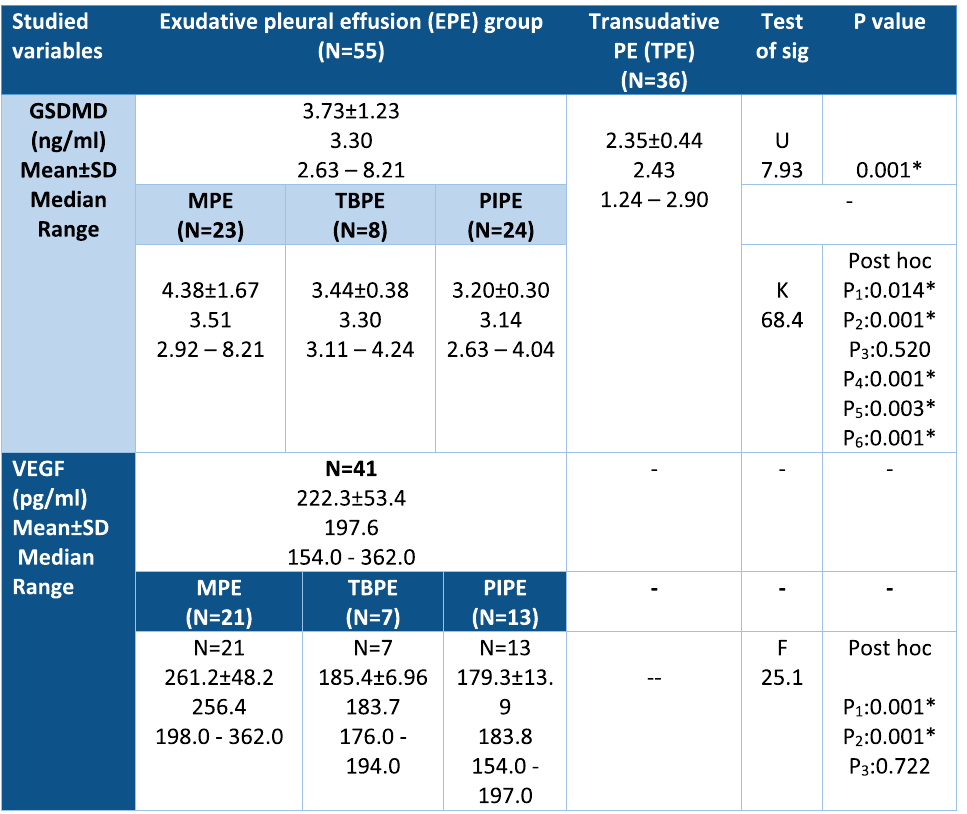
Table 2 GSDMD and VEGF levels among the studied patients ( N